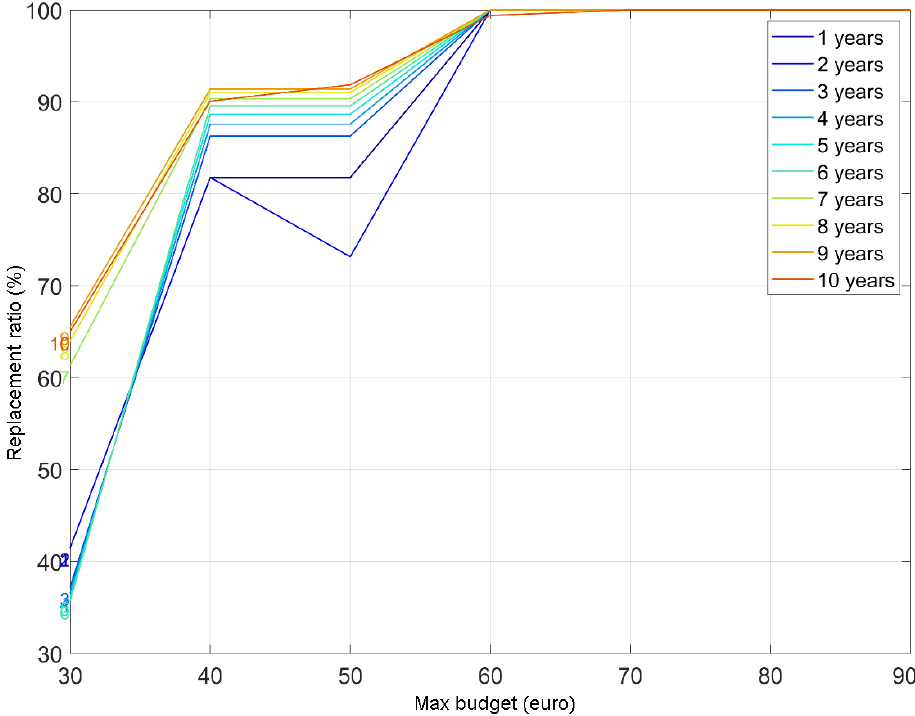
Figure 10. Replacement ratio % versus maximum client budget expressed in EUR considering the operational years for a dishwasher’s PCB.